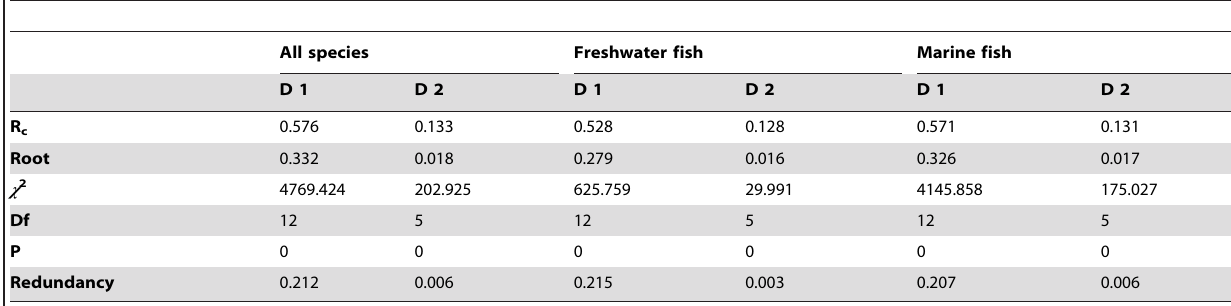
Table 1. Results of canonical correlation analyses (CANCORs) for the full data set and for freshwater and marine fish species separately.